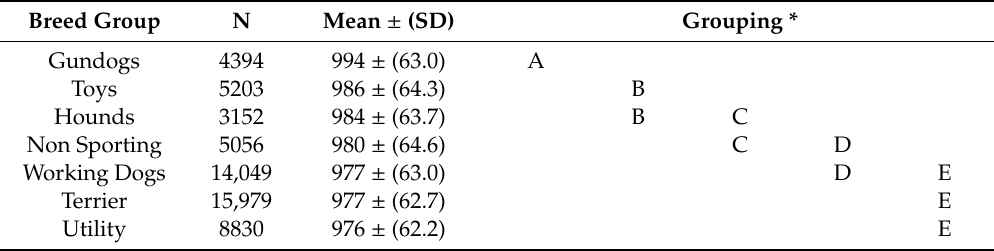
Table 3. Total numbers and Index of Relative Socio-Economic Advantage and Disadvantage (IRSAD) scores of the postcode of reported dogs in each breed group ( p <